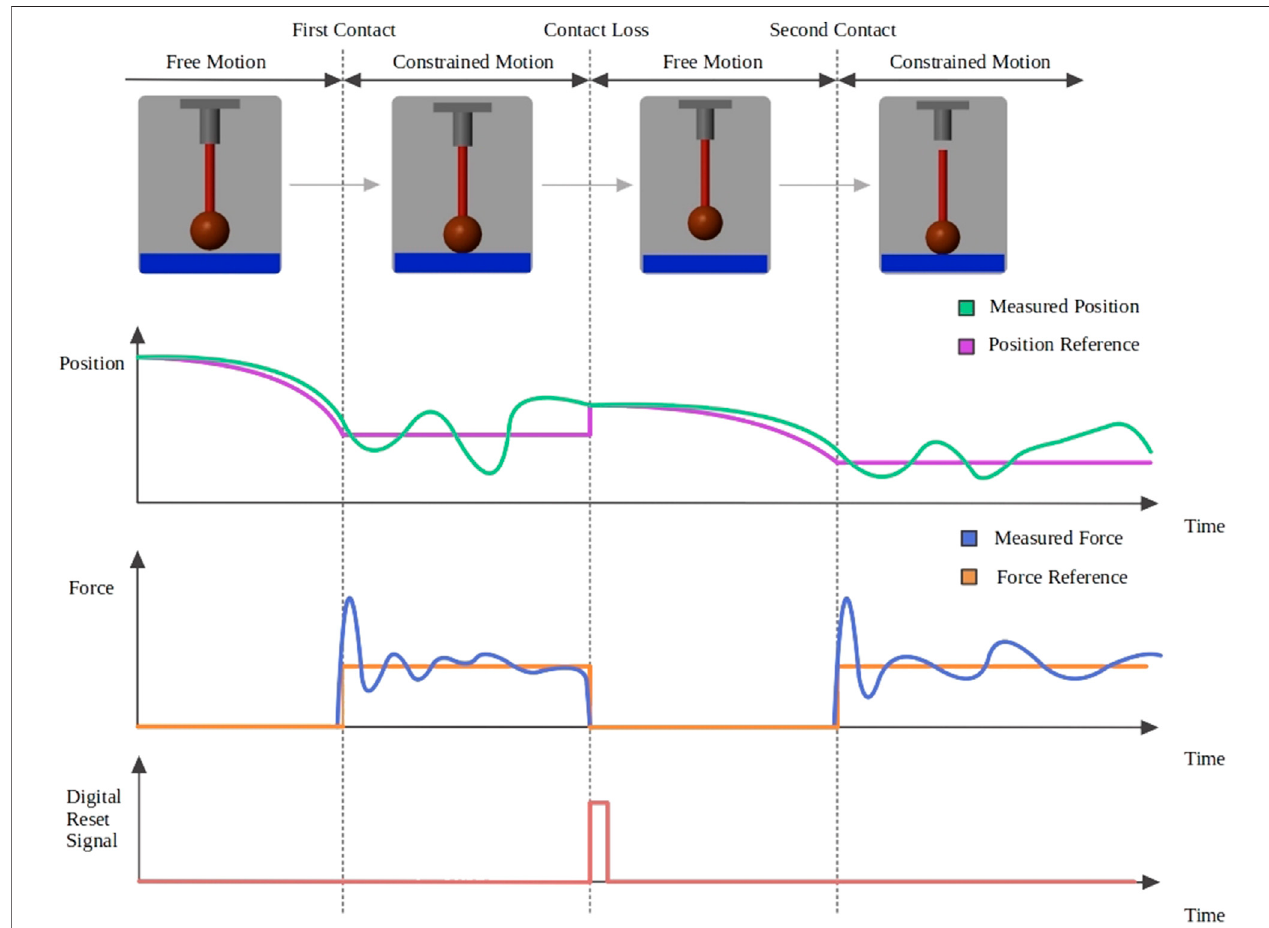
FIGURE 5 | Interaction with a sudden contact loss. Signals plotted are the commanded (purple) and measured (green) position, the commanded (orange) and measured (blue) force, and the reset signal (red) for the two integrators.